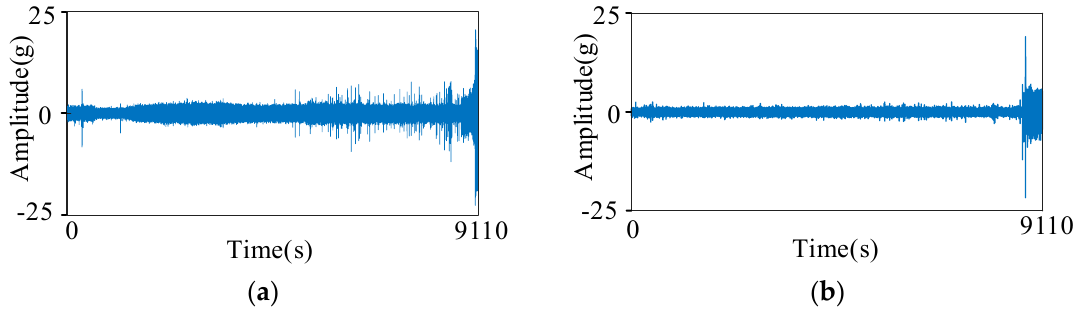
Figure 4. Vibration signals of bearing2-1. ( a ) Horizontal direction. ( b ) Vertical direction.